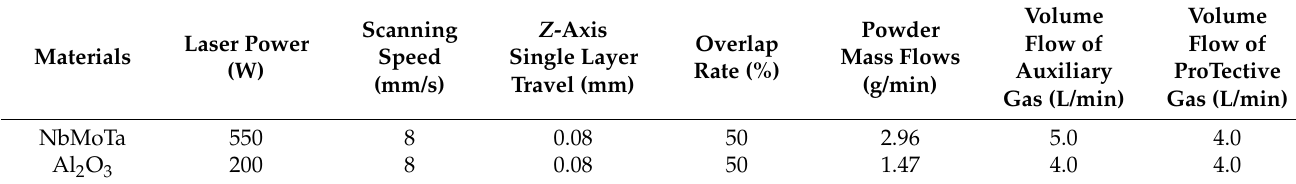
Table 1. The depositing process parameters of different materials.